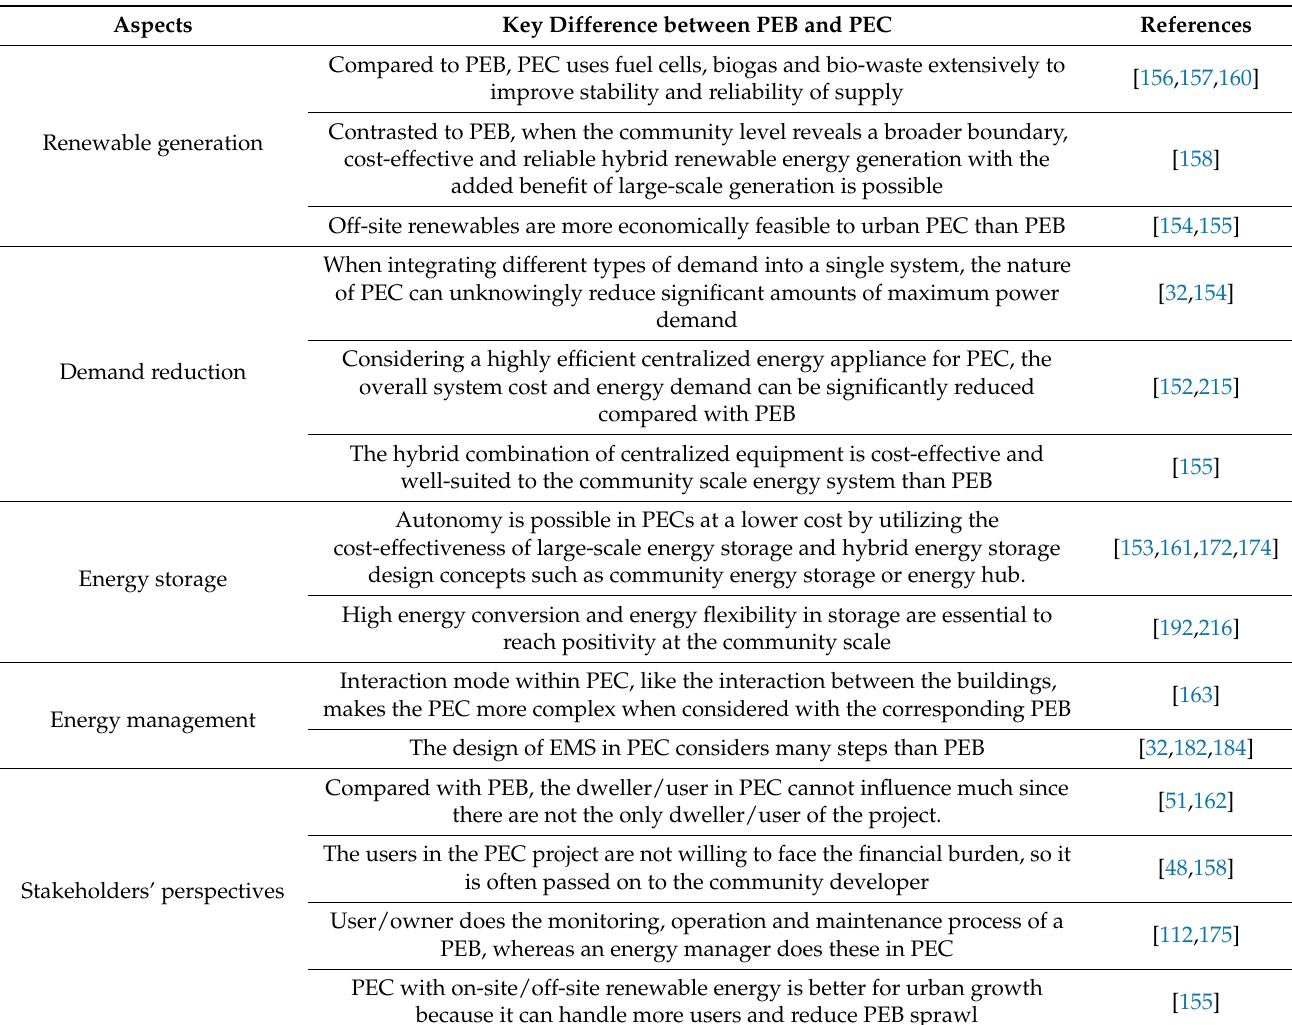
Table 7. Main differences between PEB and